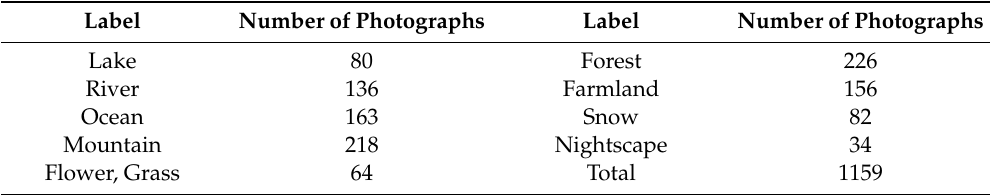
Table 11. Image classification